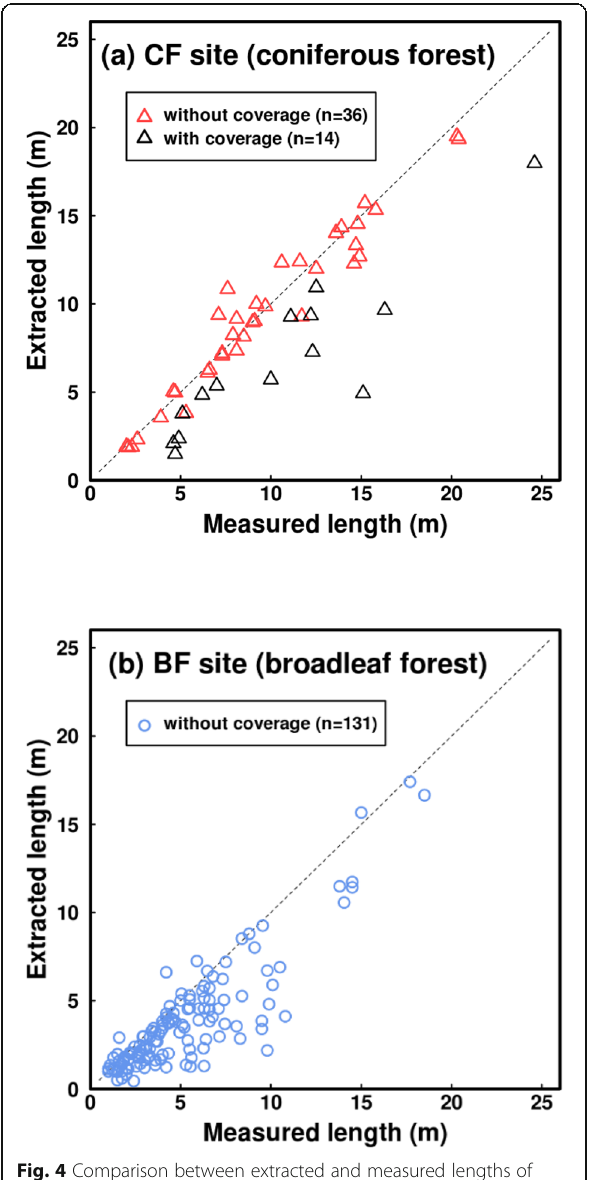
Fig. 4 Comparison between extracted and measured lengths of wood pieces: a the coniferous forest (CF) site and b the broadleaf forest (BF)